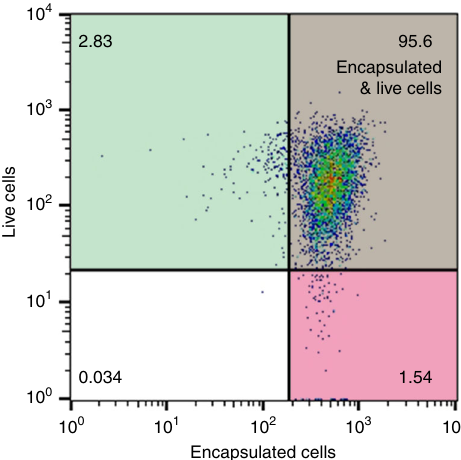
Fig. 5 Flow cytometry analysis of the cell viability and encapsulation ef fi ciency. The encapsulation ef fi ciency is evaluated by staining the surface- grafted DNA polymers with PI (red). Cell viability is visualized by staining the cytoplasm with a live cell indicator, Calcein-AM